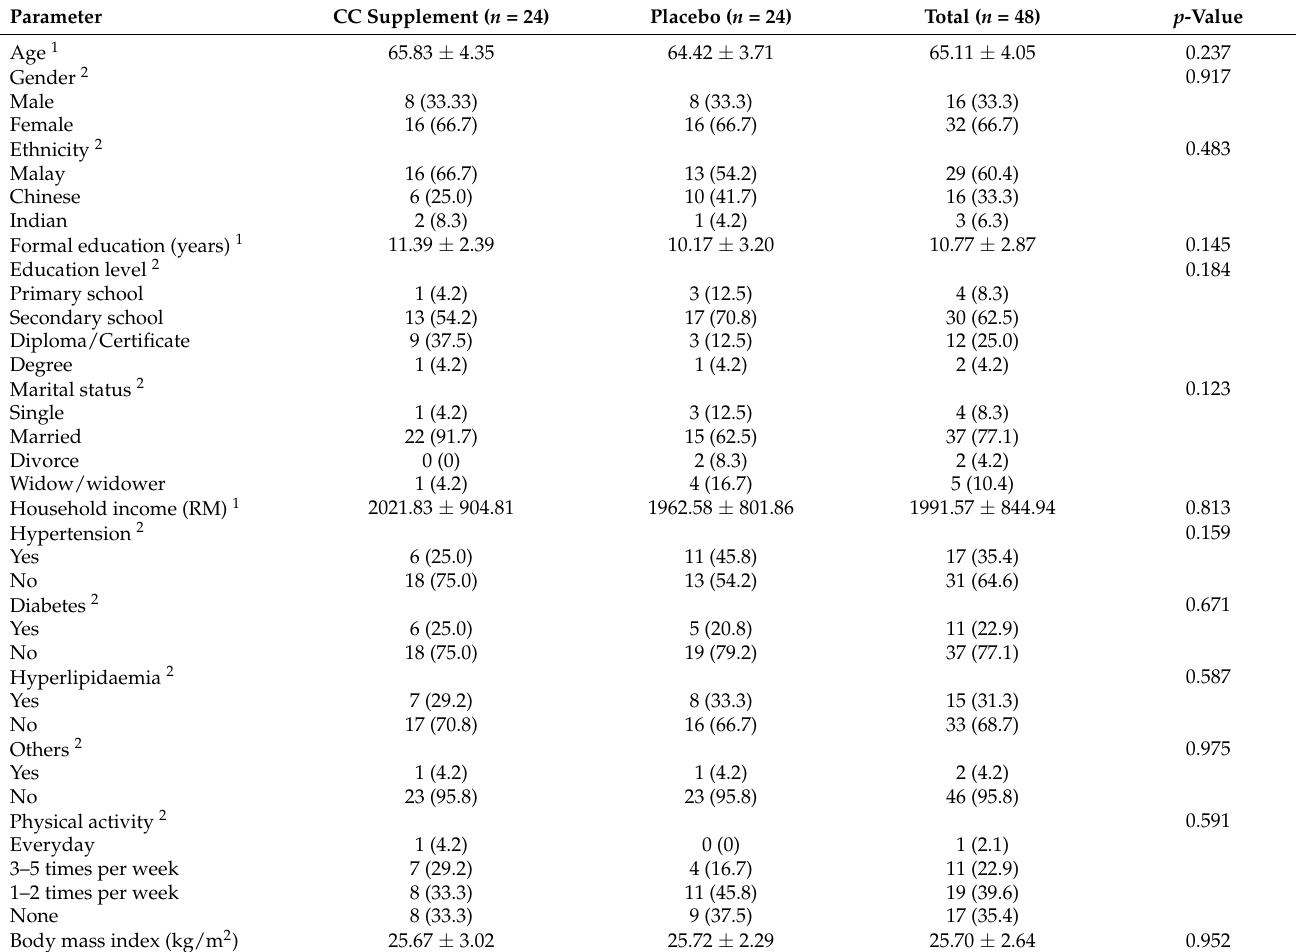
Table 3. Baseline sociodemography information and self-reported medical condition between CC supplement and placebo group subjects [presented as mean ± standard deviation or n